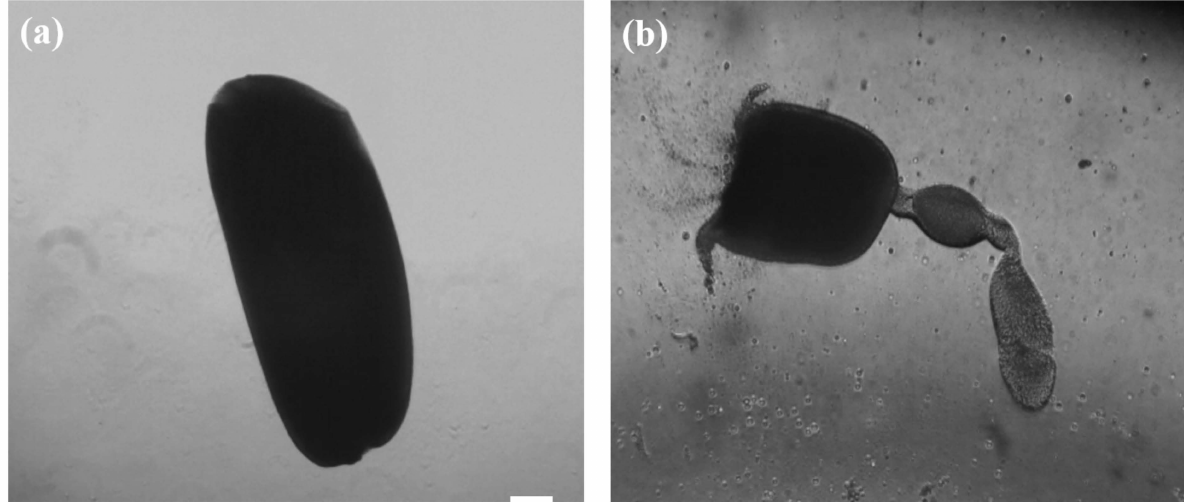
Figure 8. Comparison between mechanical and enzymatic methods used for ovarioles retrieval from female adult mealworms. ( a ) The mechanical method of isolating the ovarioles using a syringe maintains their integrity. ( b ) The enzymatic method using collagenase I damaged the outer membrane of the ovarioles. Scale bar: 50 µ m ( a , b